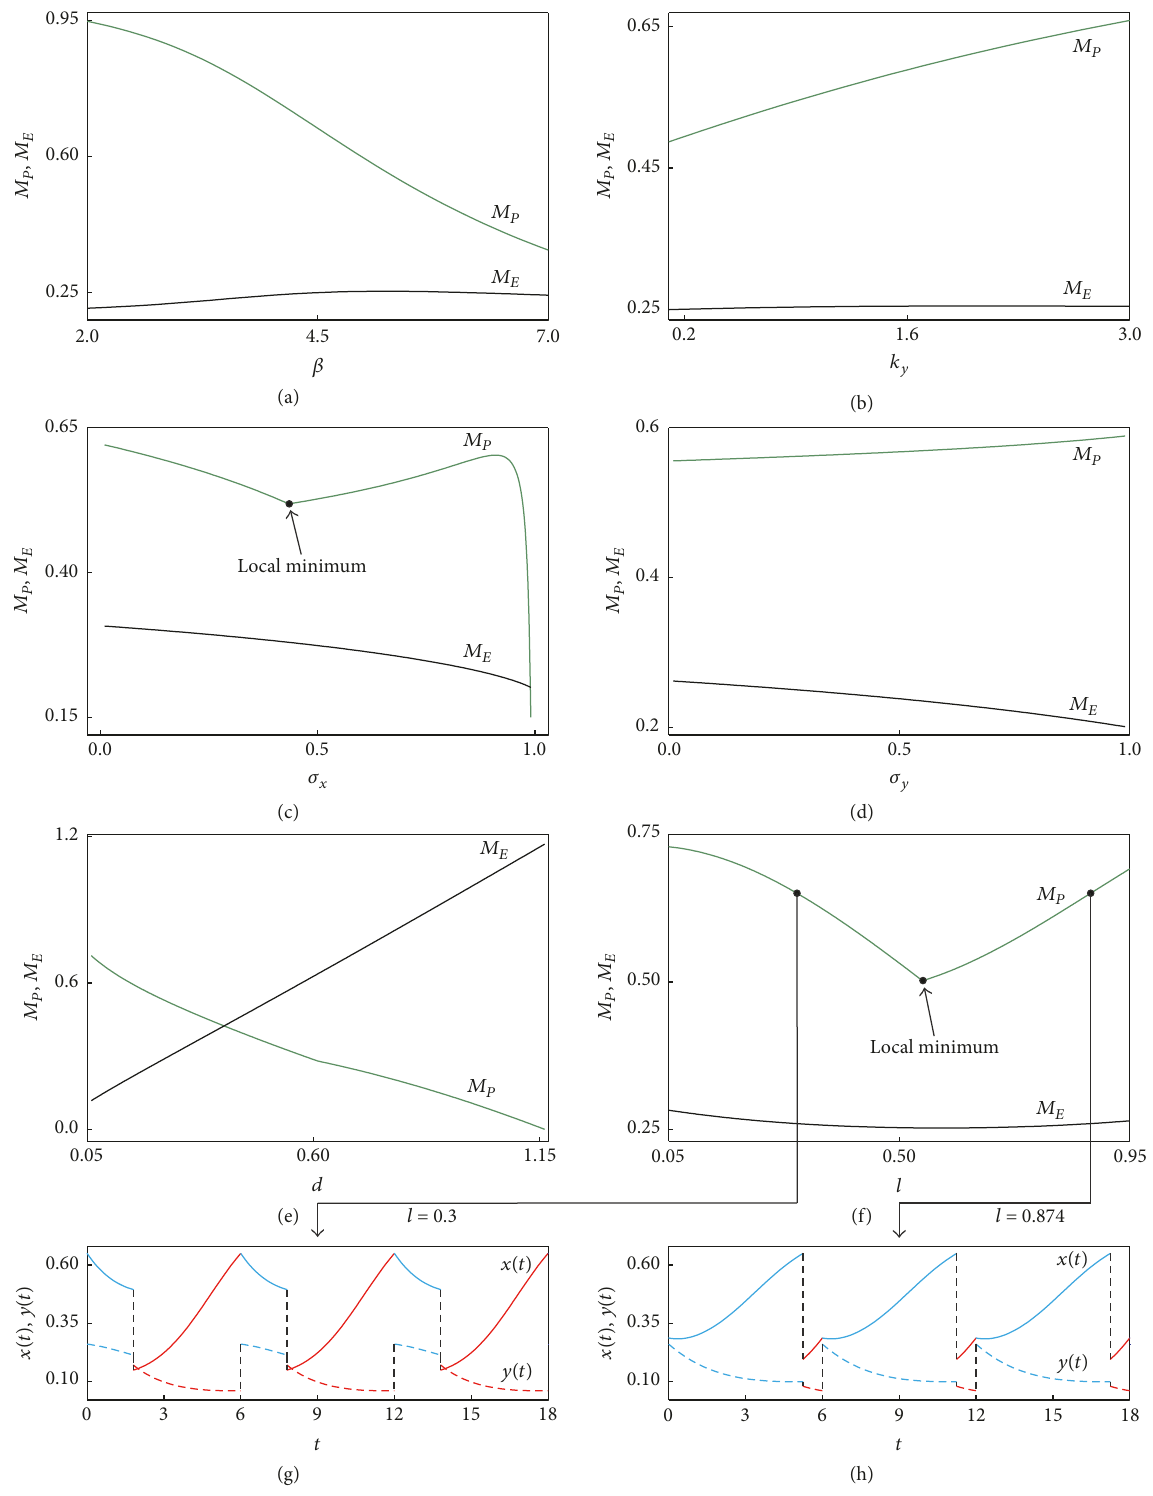
Figure 3: Numerical continuation of periodic solutions of system (14) with pests and natural enemies coexisting in the ecosystem, computed for impulse period 𝑇 = 6 . (a)–(f) show the continuation with respect to 𝛽 , 𝑘 𝑦 , 𝜎 𝑥 , 𝜎 𝑦 , 𝑑 , and 𝑙 , respectively. In each diagram, two curves are shown, corresponding to the peak values of pest ( 𝑀 𝑃 , green) and natural enemy ( 𝑀 𝐸 , black) populations. (g) and (h) present time histories for which 𝑀 𝑃 = 0.65